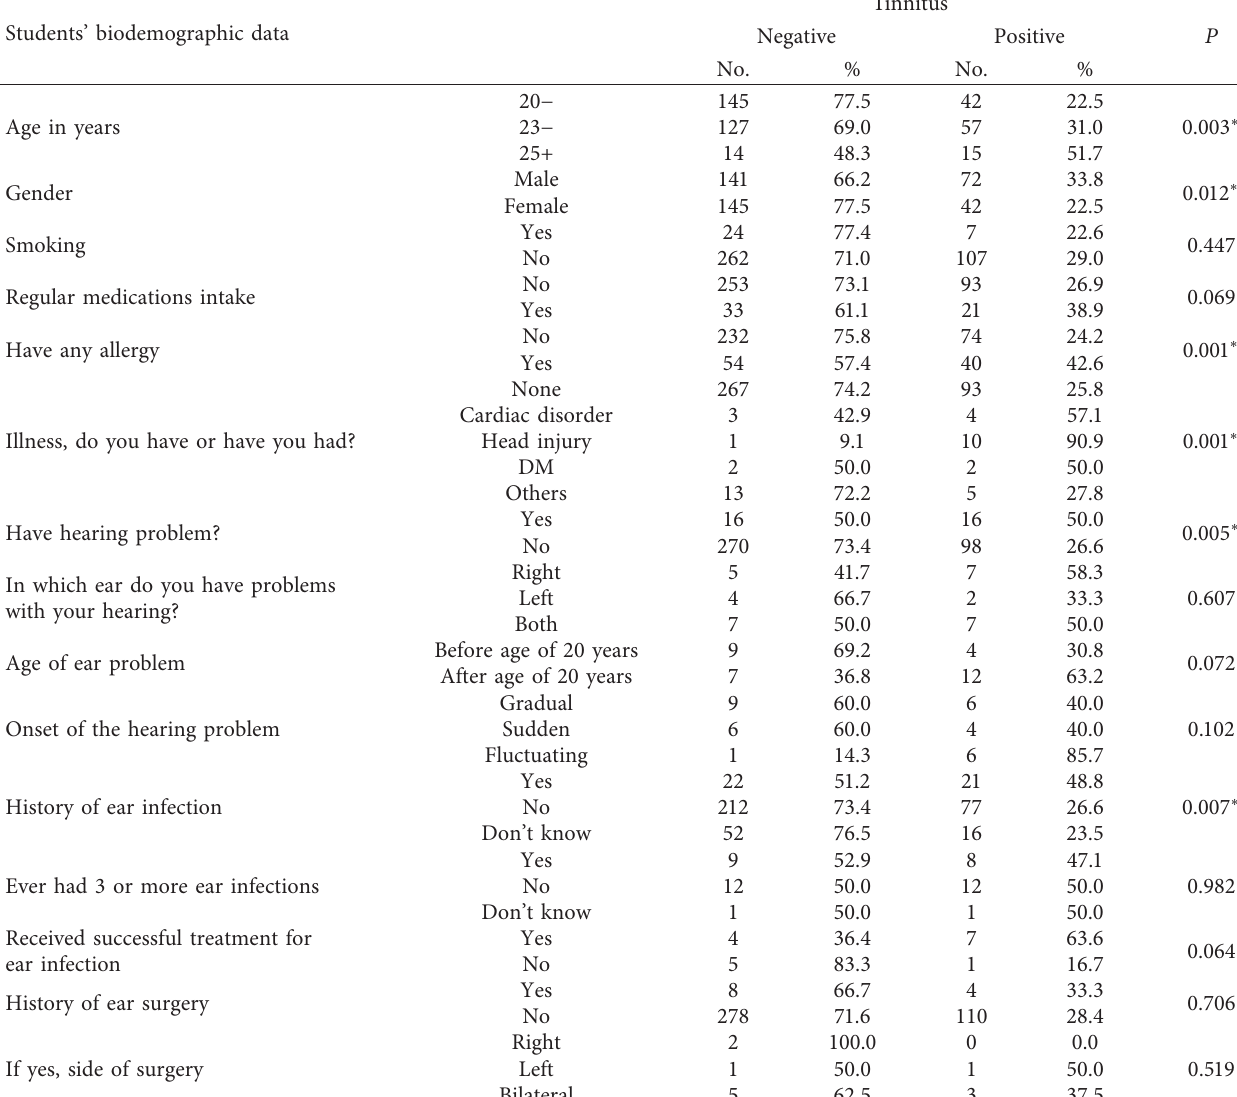
Table 2: Distribution of students’ tinnitus status according to their biodemographic data. Students’ biodemographic